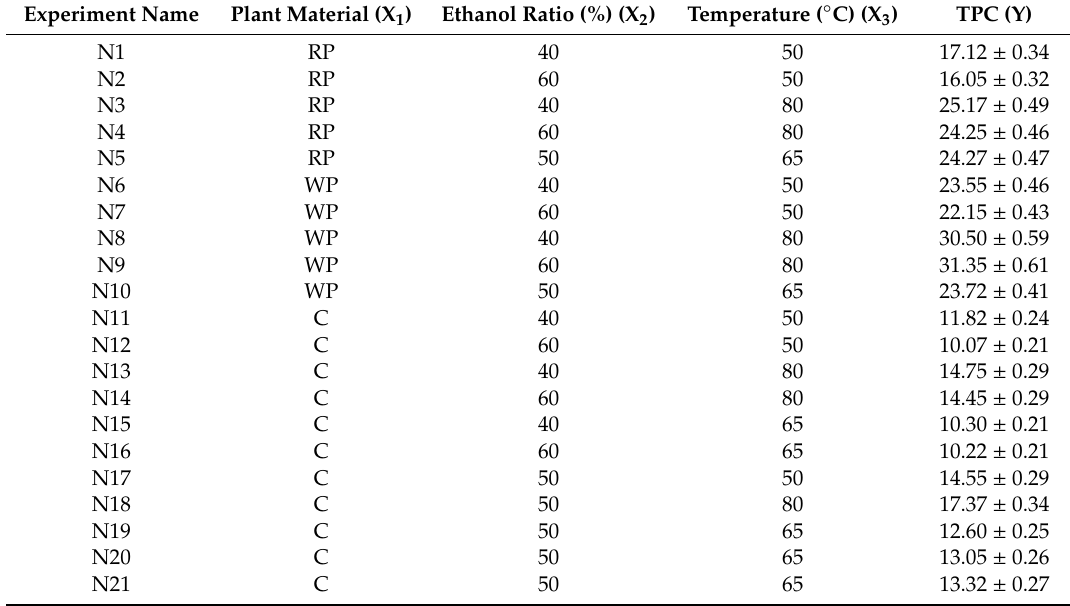
Table 2. Experimental design matrix and results obtained for total polyphenols content